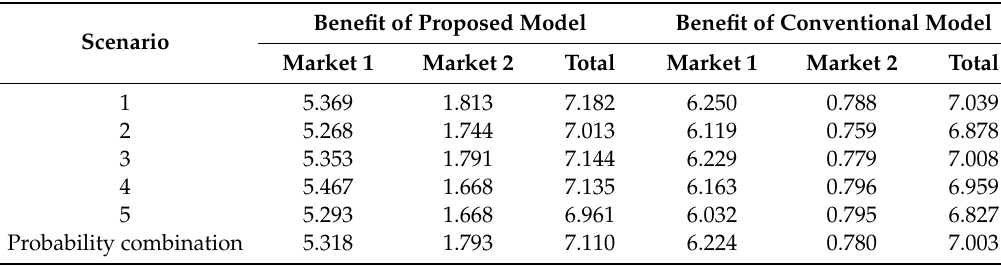
Table 7. Operation results comparison of multi scenarios (Unit: Billion